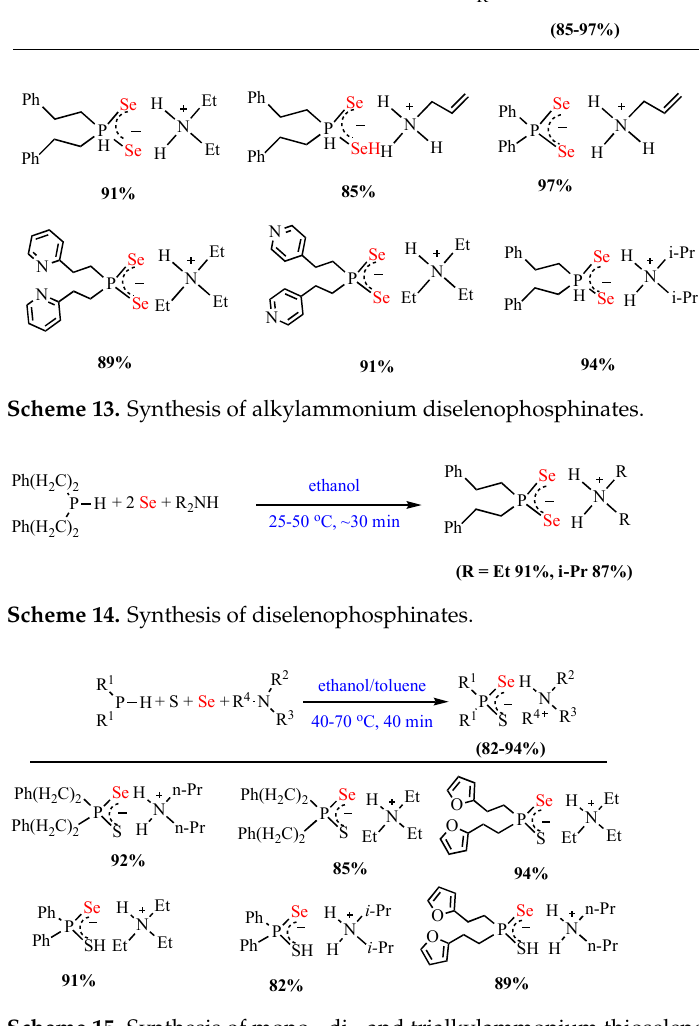
Scheme 15. Synthesis of mono-, di-, and trialkylammonium